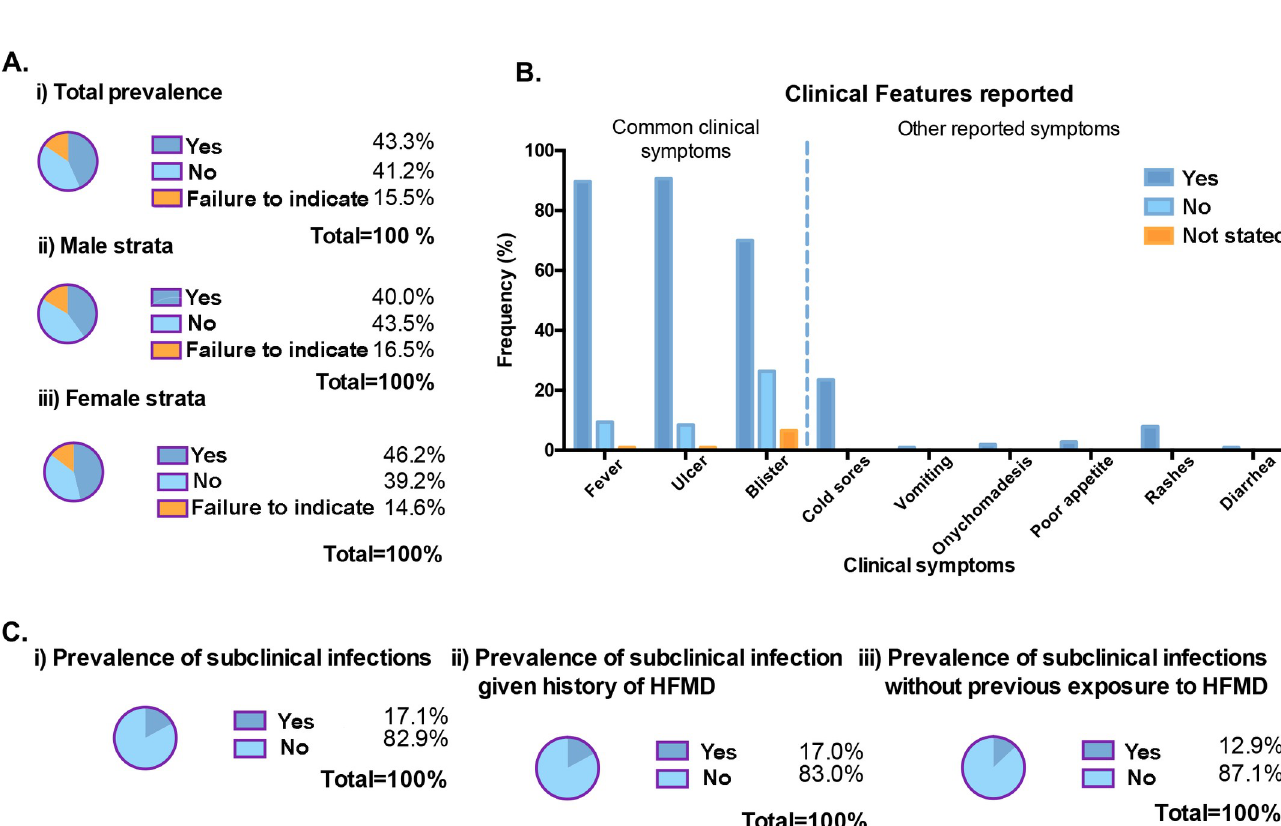
Fig 5. Previous HFMD exposure reported from healthy pediatric volunteers, 2012–2018. (A) The prevalence of HFMD is calculated based on recall from the questionnaires distributed to parents and/or guardians. i ) Total prevalence of HFMD before stratification. ii ) & iii ) are prevalence that were stratified according to gender. (B) Clinical features were recorded based on recall during the period with which the child came down with HFMD. (C) Prevalence of subclinical infection among healthy pediatric volunteers according to the pan-entero RT-PCR assay. i ) Overall prevalence of subclinical infections in childcare volunteers cohort while ii ) & iii ) are prevalence of the former stratified according to previous history of